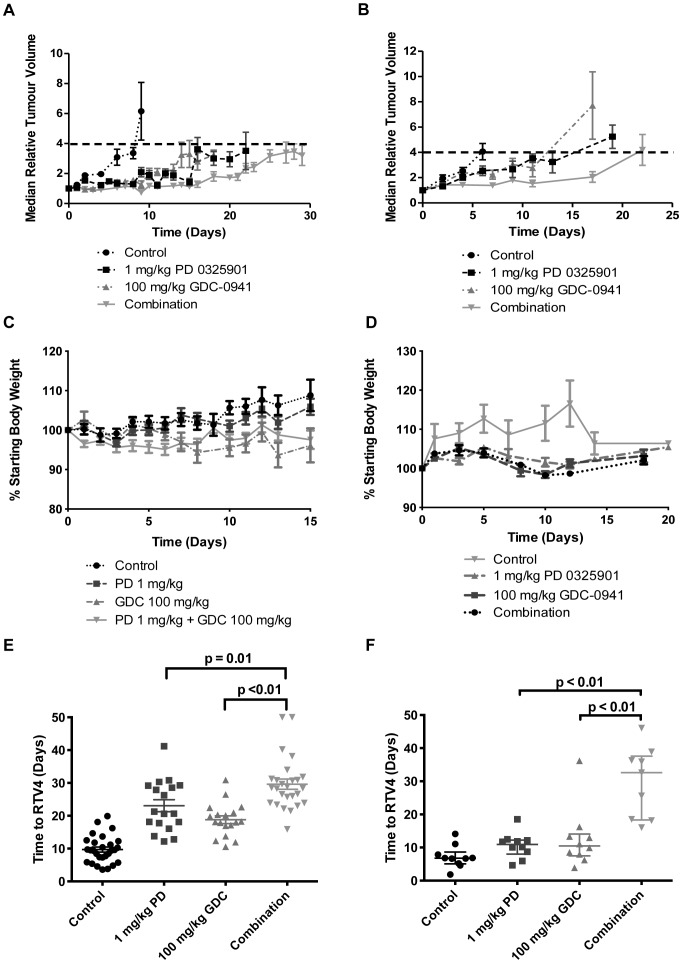
Efficacy and tolerability of GDC-0941 and PD 0325901 in mice bearing human colorectal tumour xenografts.HCT116 (A, C, E) and HT29 (B, D, F) tumour xenografts were treated with either vehicle control, 1 mg/kg of the MEK inhibitor PD 0325901 and 100 mg/kg of the PI3K inhibitor GDC-0941 alone, or 1 mg/kg of the MEK inhibitor PD 0325901 and 100 mg/kg of the PI3K inhibitor GDC-0941 in combination, p.o. once daily for 14 days. [A–B] Tumour growth curves: Data are presented as the median relative tumour volume (RTV), where the growth is calculated for each tumour relative to its size on day 0. Points represent the median of the 10 mice in each group. The dashed line shows the point at which tumours reached four times the initial volume (RTV4). [C–D] Effects on body weight: Data are presented as a percentage of starting body weight. Points represent the mean of the 10 mice in each group ± standard error. [E–F] Time taken for xenografts to reach four times the initial volume (time to RTV4): Data are presented as the time taken by each individual tumour in each group to quadruple in size, and lines to represent the mean of the mice in each group ± standard error. P values are given where the combination is significantly different from either agent alone (p≤0.05).